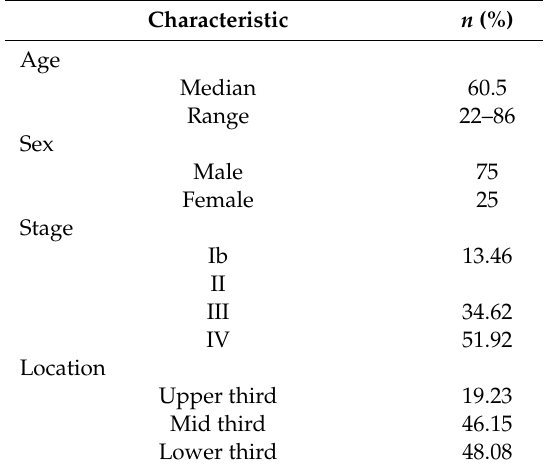
Figure 3. MINA53 protein expression analysis in human gastric cancer tissues. ( A ) Immunoblot results of human gastric cancer and adjacent normal tissues. ( B ) Pairwise analysis and box-plot overview of the relative MINA53 protein expression comparison from validated human gastric cancer tissue samples; normalized expression was done by measuring the relative density of MINA53 / β -actin immunoblot results. Statistical significance was calculated using the paired t-test. The whole Western blot images please find in Figure S1. Table 1. The characteristics of gastric cancer patients used in this